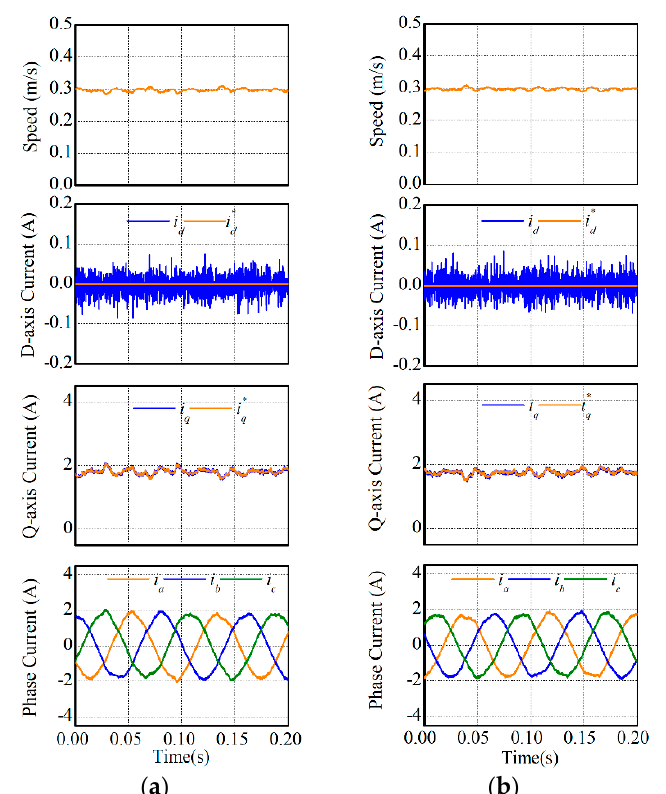
Figure 7. Steady-state performances under 0.3 m/s: ( a ) MPCC-I and ( b ) MPCC-II.